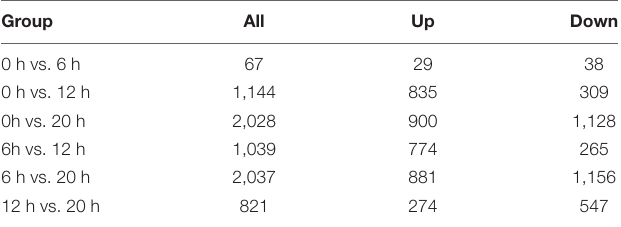
TABLE 1 | Differentially expressed genes at different time points post infection in chicken DF1 cells. Group